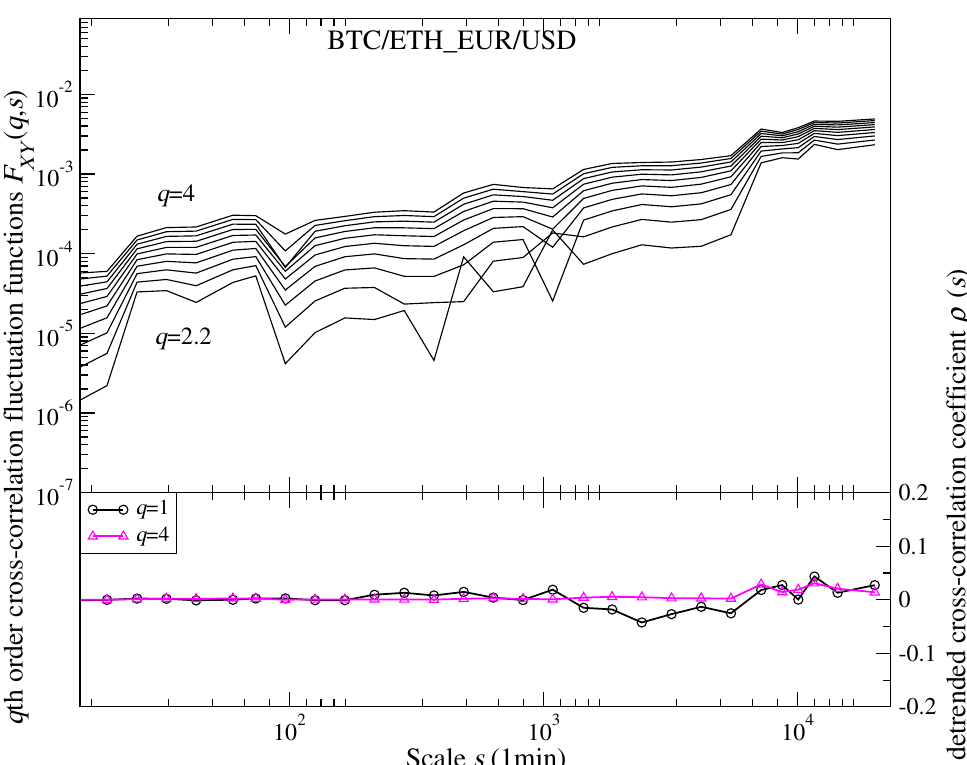
Figure 11. (Color online) Family of the q th-order fluctuation cross-covariance functions F XY ( q , s ) , for different values of q in steps of 0.2 The upper-most lines correspond to q = 4, whereas the bottom ones to those for which F XY ( q , s ) are still positive (upper panel) and the ρ q ( s ) coefficients as functions of the temporal scale s for q = 1 and q = 4, calculated for the cross-correlation between BTC/ETH and EUR/USD exchange rates (lower